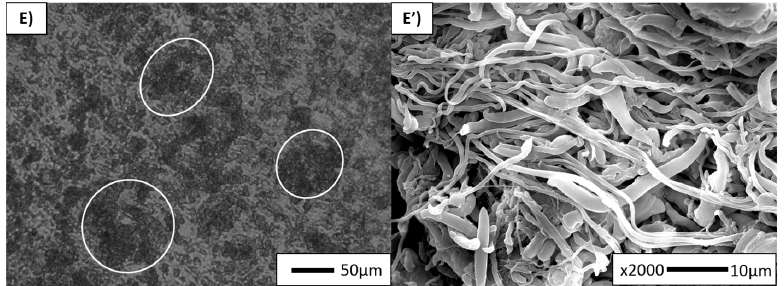
Figure 3. Microstructures of MFCs samples obtained via POM along the flow direction: ( A ) MFC; ( B ) POE EXT ; ( C ) POE- g -MA EXT ; ( D ) POE IM ; ( E ) POE- g -MA IM . Microstructures of MFCs samples obtained via SEM in transverse direction: ( A’ ) MFC (PP partially etched after 1.5 h in hot xylene); ( B’ ) POE EXT (PP partially etched after 1.5 h in hot xylene); ( C’ ) POE- g -MA EXT (PP partially etched after 3 h in hot xylene); ( D’ ) POE IM (PP partially etched after 3 h in hot xylene); ( E’ ) POE- g -MA IM (PP partially etched after 3 h in hot xylene).